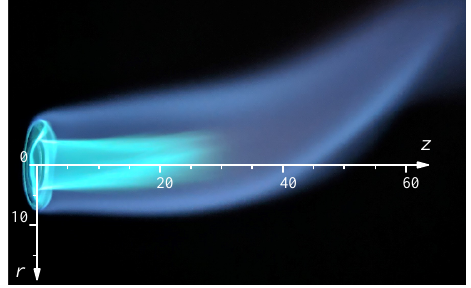
Figure 15. Image of the flame and coordinate system for the heating position.